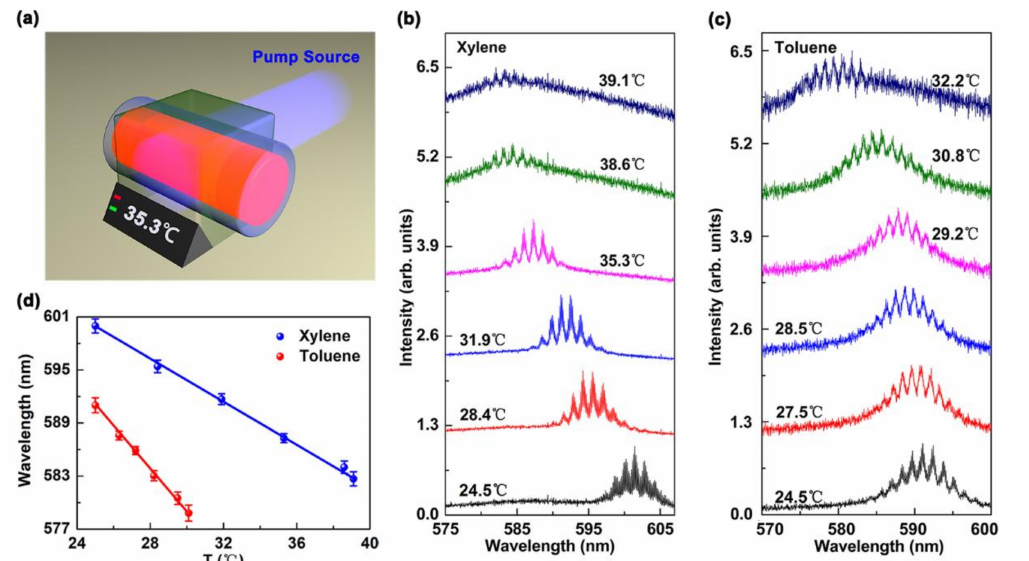
Figure 4. Performance of the continuously tunable capillary-tube liquid-polymer WGM laser. ( a ) Schematic of the heating platform equipment. ( b , c ) Varying emission spectrum for MDMO-PPV dissolved in xylene or toluene as a function of temperature ( T ). ( d ) Device emission wavelength tuning range for the devices with different organic solvents, i.e., xylene (blue spheres and the fitting line) and toluene (red spheres and the fitting